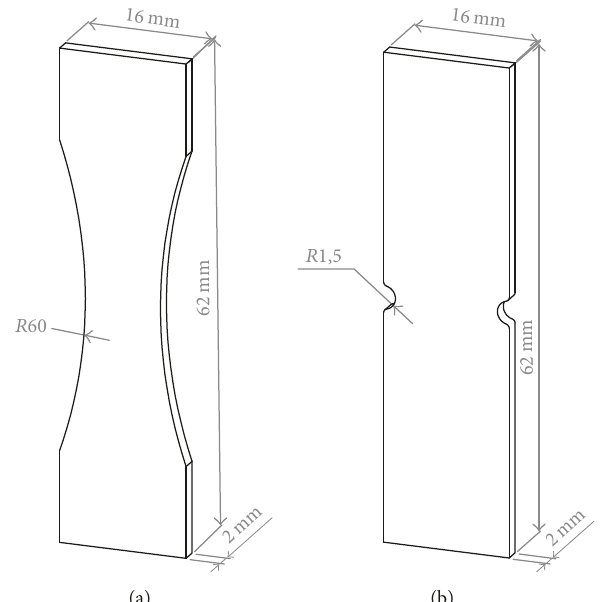
Figure 1: Illustration of the specimen’s geometries used for injection molding: unnotched specimen (a) and notched specimen (b).